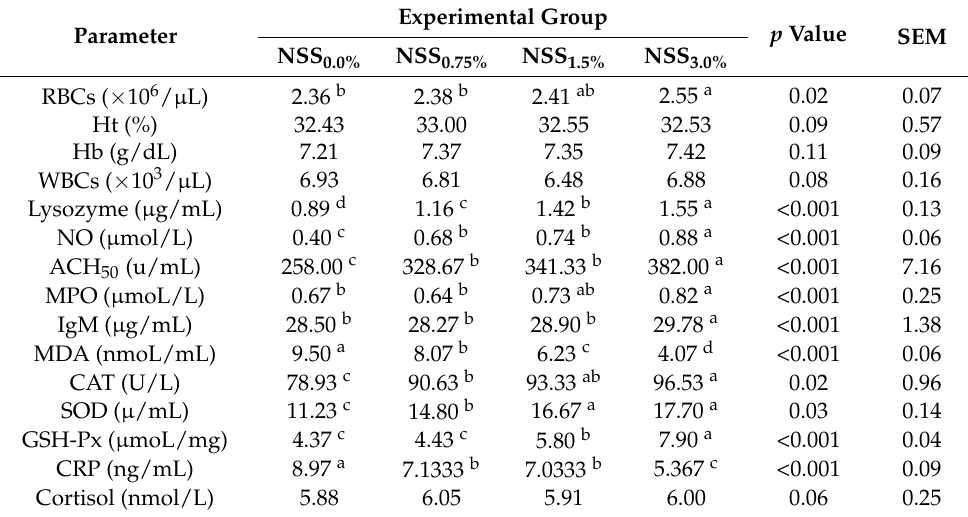
Table 5. Hematological, immunological, and antioxidant markers of Nile tilapia ( O. niloticus ) fed diets enriched with different levels of a microalgae mix (NSS) containing Nannochloropsis oculate and Schizochytrium and Spirulina species at equal proportions (1:1:1) for 12 weeks.